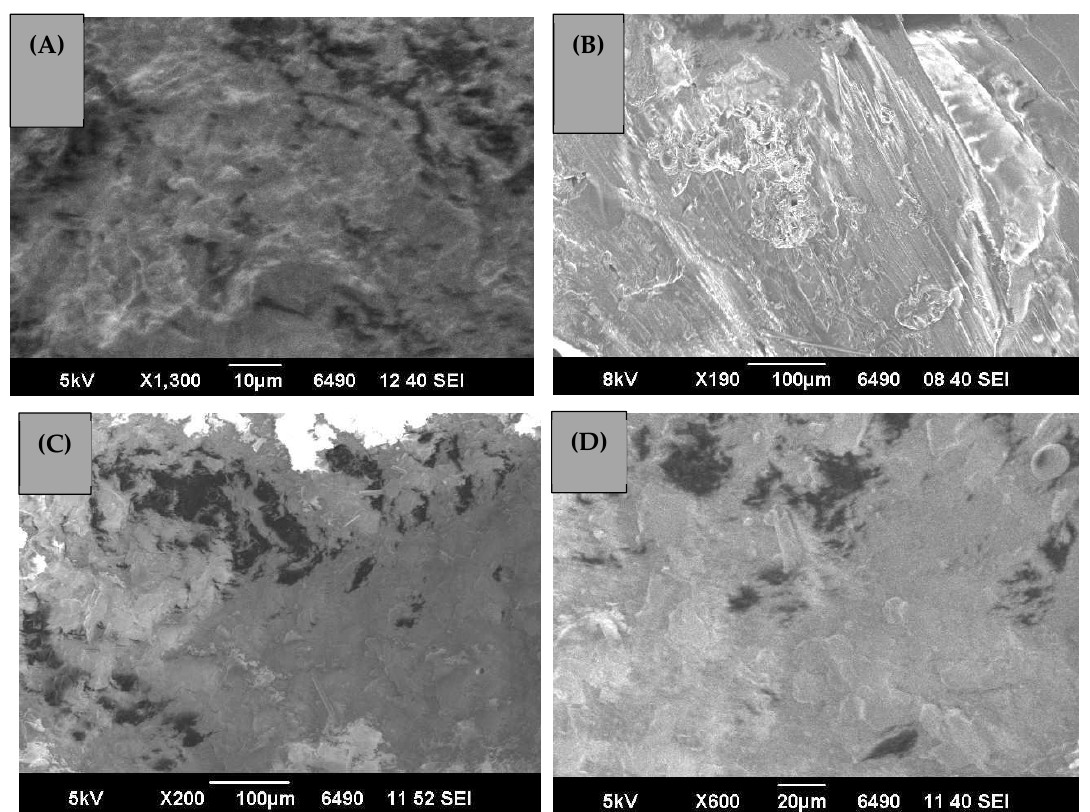
Figure 6. Scanning electron micrograph (SEM) of the GO-PU composites. ( A ) 10 μ m scan of PUM4. ( B ) 100 μ m scan of PUM4. ( C ) 100 μ m scan of PUH4. ( D ) 10 μ m scan of PUH4.